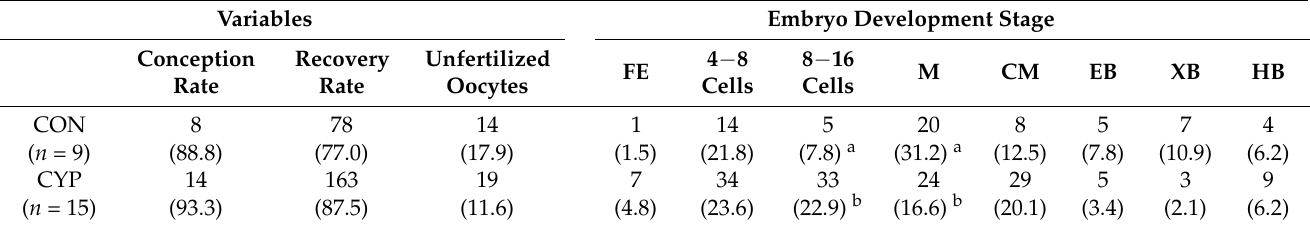
Table 2. Fertilization rate (%), embryo recovery rate (%), unfertilized oocytes (%), fragmented embryos (FE; %), 4–8 cells embryos (%), 8–16 cells embryos (%), morula (M; %), compact morula (CM; %), early blastocyst (EB; %), expanded blastocyst (XB; %) and hatched blastocyst (HB; %) of gilts subjected to estrus synchronization protocol using estradiol cypionate and PGF2 α .